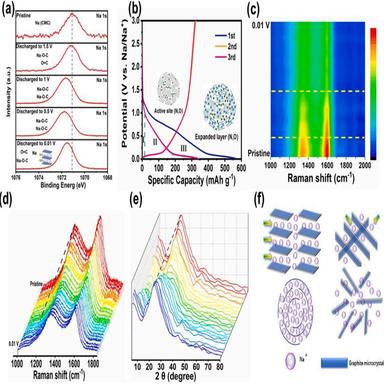
Na-ion Storage Mechanism of NHC-5. a) ex-XPS patterns of Na1s in the charging states of NHC-5 in different potentials (pristine, 1.5, 1, 0.5, and 0.01 V). b) The analysis of three kinds of Na-ion storage mechanisms based on the discharge profiles. c-d) in-situ Raman patterns of NHC-5 in the different discharging states. e) ex-XRD patterns of NHC-5 in different potentials. f) Schematic illustration of Na-ion storage mechanism in NHC-5.